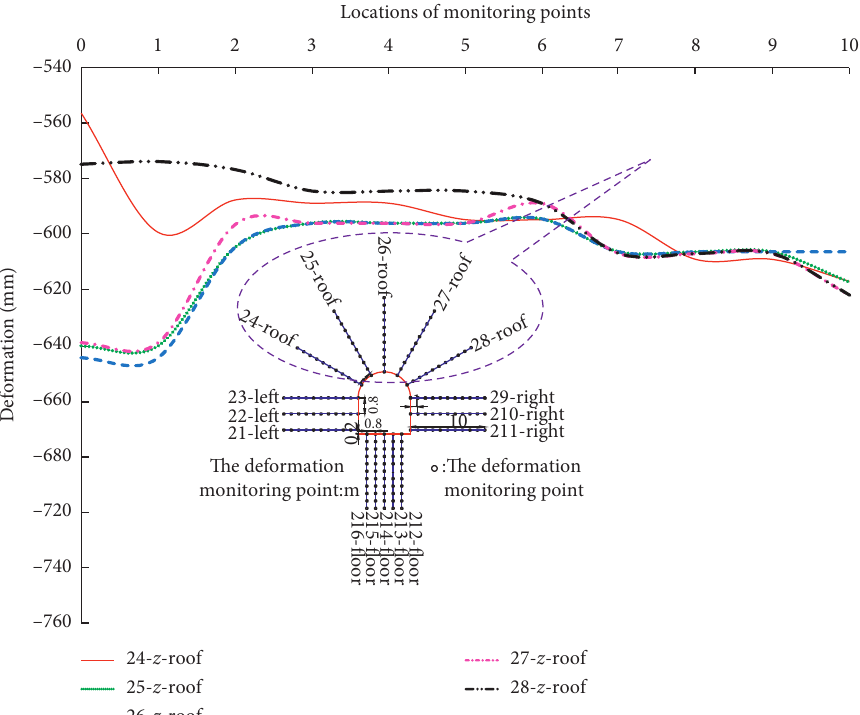
Figure 9: The deformation law of the surrounding rock of roadway roof.